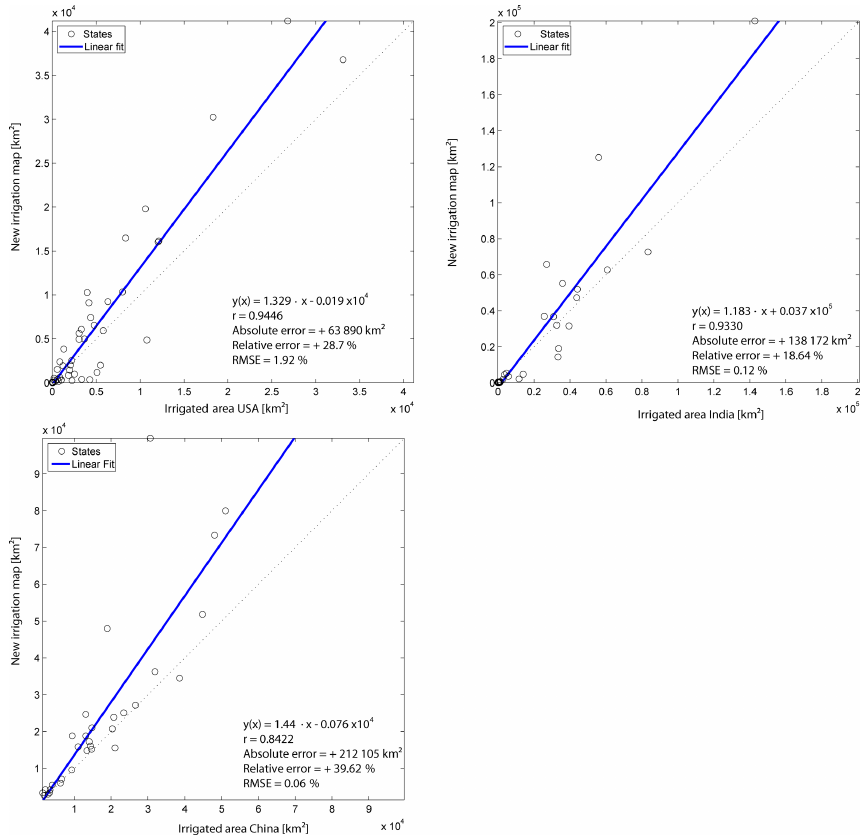
Figure 10. Regression plots of the compared our irrigation map compared to regional data sets of the USA (Ozdogan et al., 2010), India (Ambika et al., 2016) and China (Zhu et al., 2014). The blue line is the linear fit and the dotted black line the linear